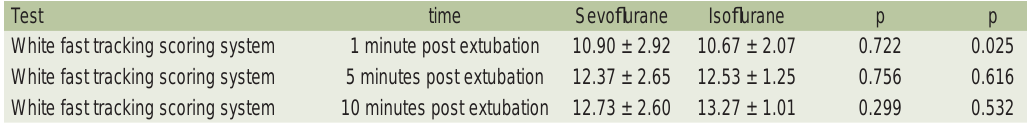
TABLE 4. Recovery rate measured with White fast tracking scoring system, comparison of sevofl urane and isofl urane anesthesia